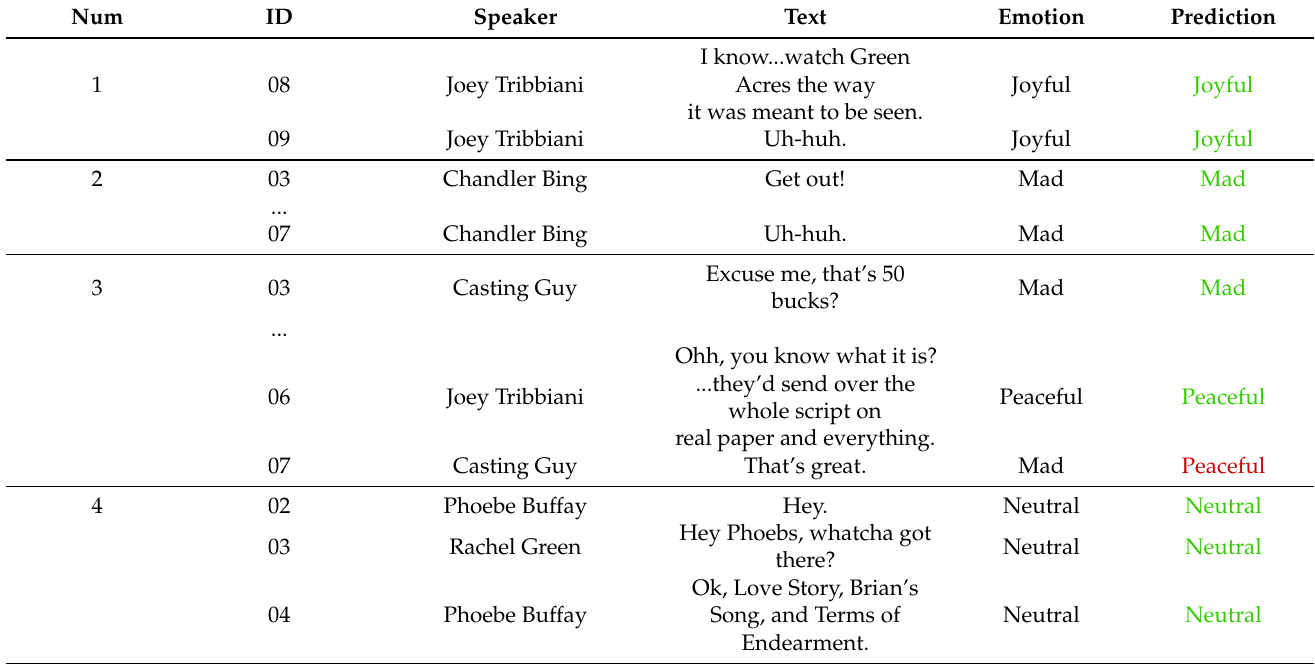
Table 5. Results of the three case studies, “ID” is the order of the utterances in the dialogue. We use green and red to highlight correct and incorrect predictions